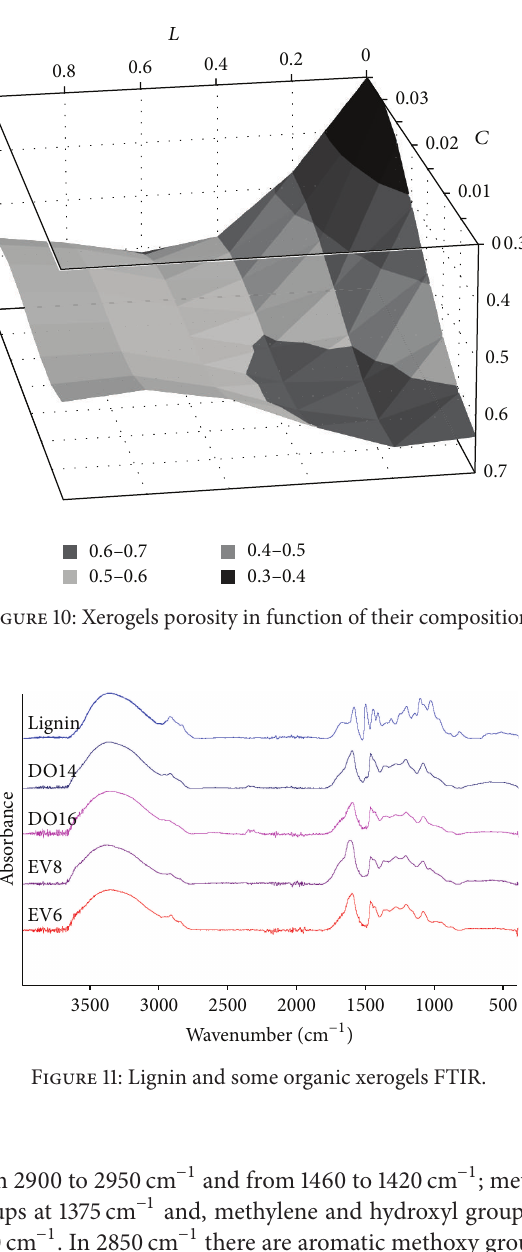
from 2900 to 2950 cm −1 and from 1460 to 1420 cm −1 ; methyl groups at 1375 cm −1 and, methylene and hydroxyl groups at 1330 cm −1 . In 2850 cm −1 there are aromatic methoxy